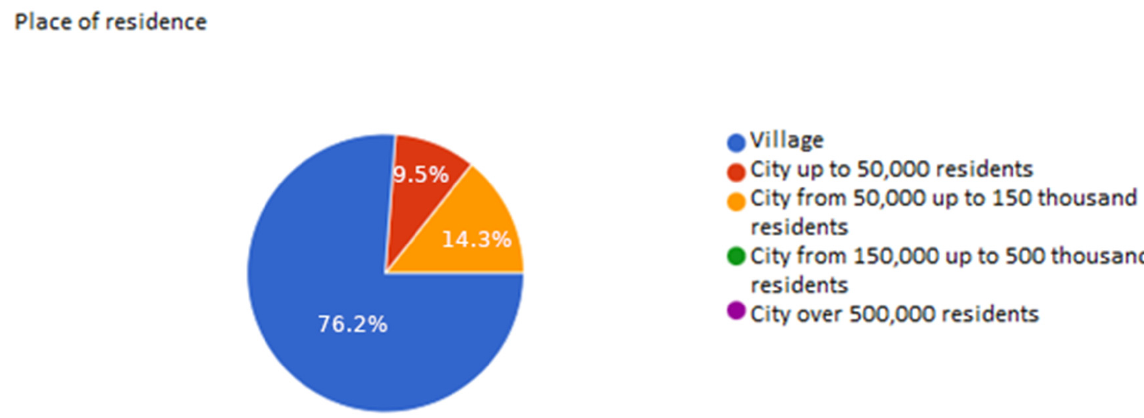
Figure 24. Place of residence of the respondents.